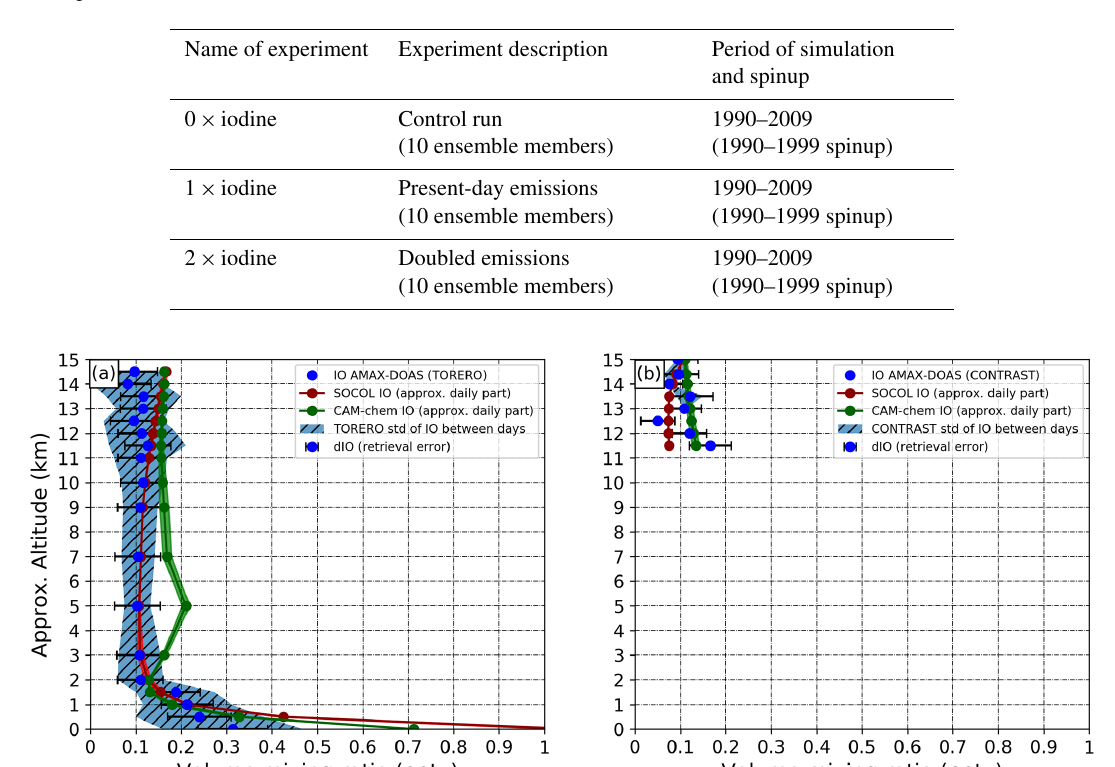
Figure 4. January–February averages of modeled and observed IO in the tropical troposphere [15 ◦ N–15 ◦ S] for (a) the TORERO cam- paign from Costa Rica (January–February 2012, 10 ◦ N–40 ◦ S, 250–285 ◦ E), and (b) the CONTRAST campaign from Guam (January– February 2014, 40 ◦ N–15 ◦ S, 115–175 ◦ E). Red line: IO from SOCOL-AERv2-I. Green line: IO from CAM-chem. Blue dots: IO observed by AMAX-DOAS. Shadings: IO standard deviations of all modeled and measured IO during the January–February